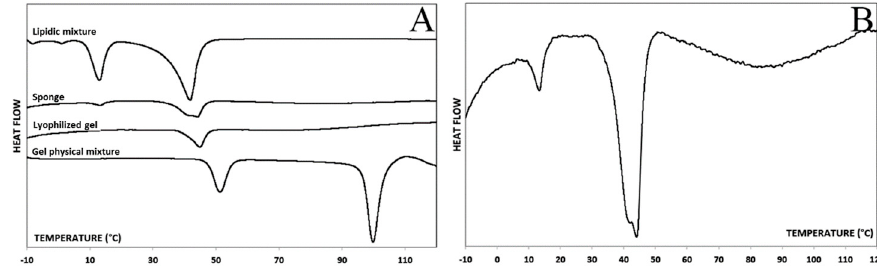
Figure 3. ( A ) Thermograms of the lipid mixture, Sponge-C, lyophilized gel, and gel physical mixture; ( B ) Thermogram of the Sponge-C with higher magnification.